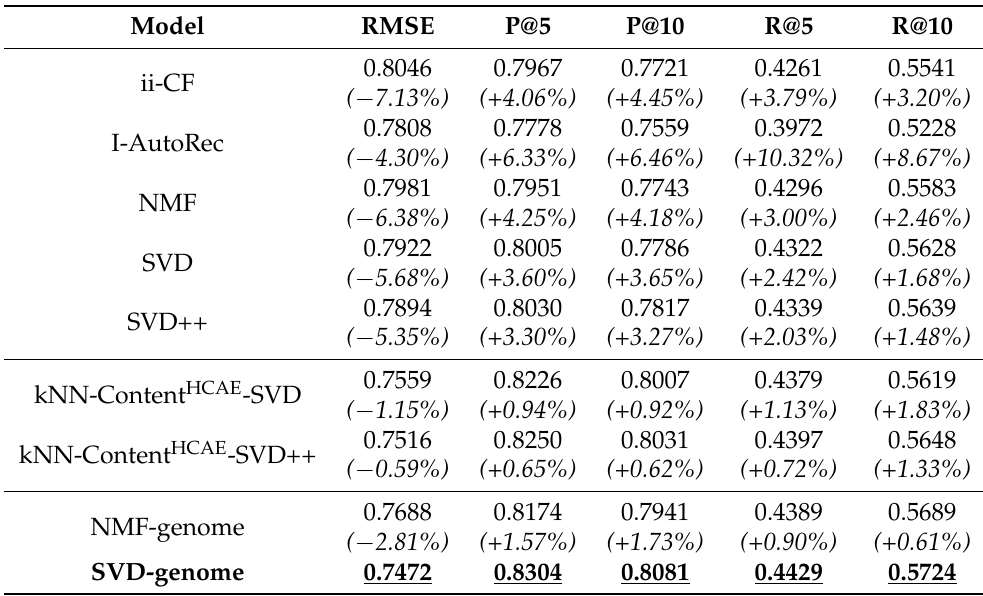
Table 6. Performance comparison between the proposed models utilizing 600 HCAE-generated feature vectors and the baseline